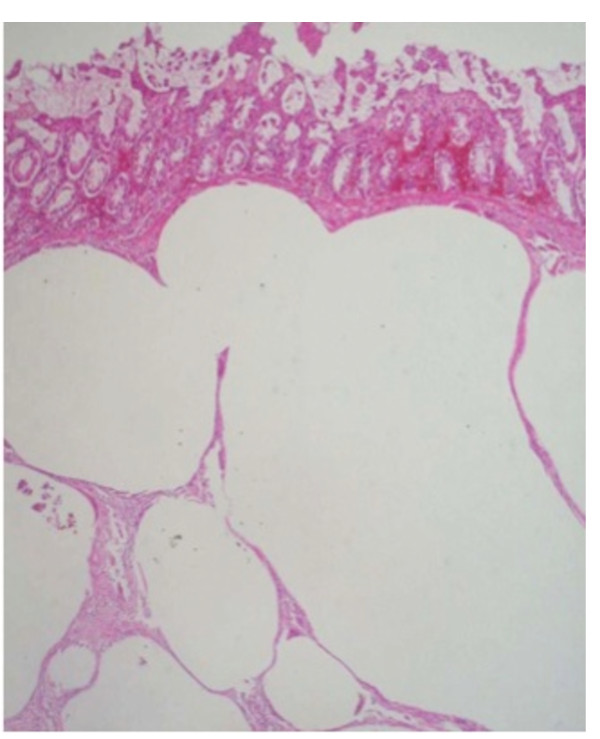
Microscopic histological appearance of the ascending colon. Microscopic histological appearance of the specimen of the ascending colon shows multiple foci of pneumatosis, which are compatible with pneumatosis cystoides intestinalis. This study also shows hemorrhage within the mucosa without any necrotic features.